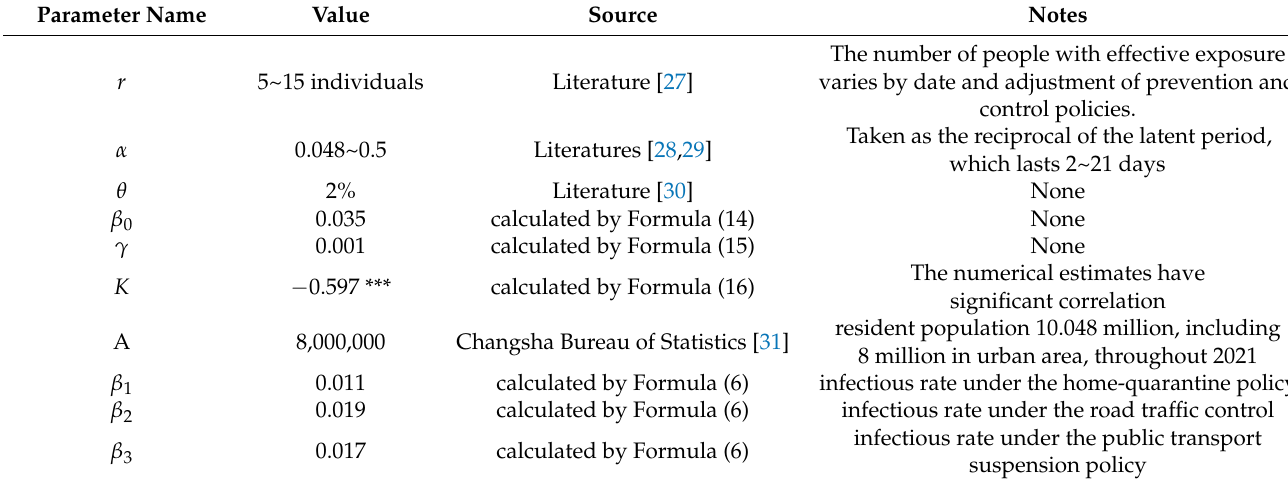
Table 5. Values of all parameters.